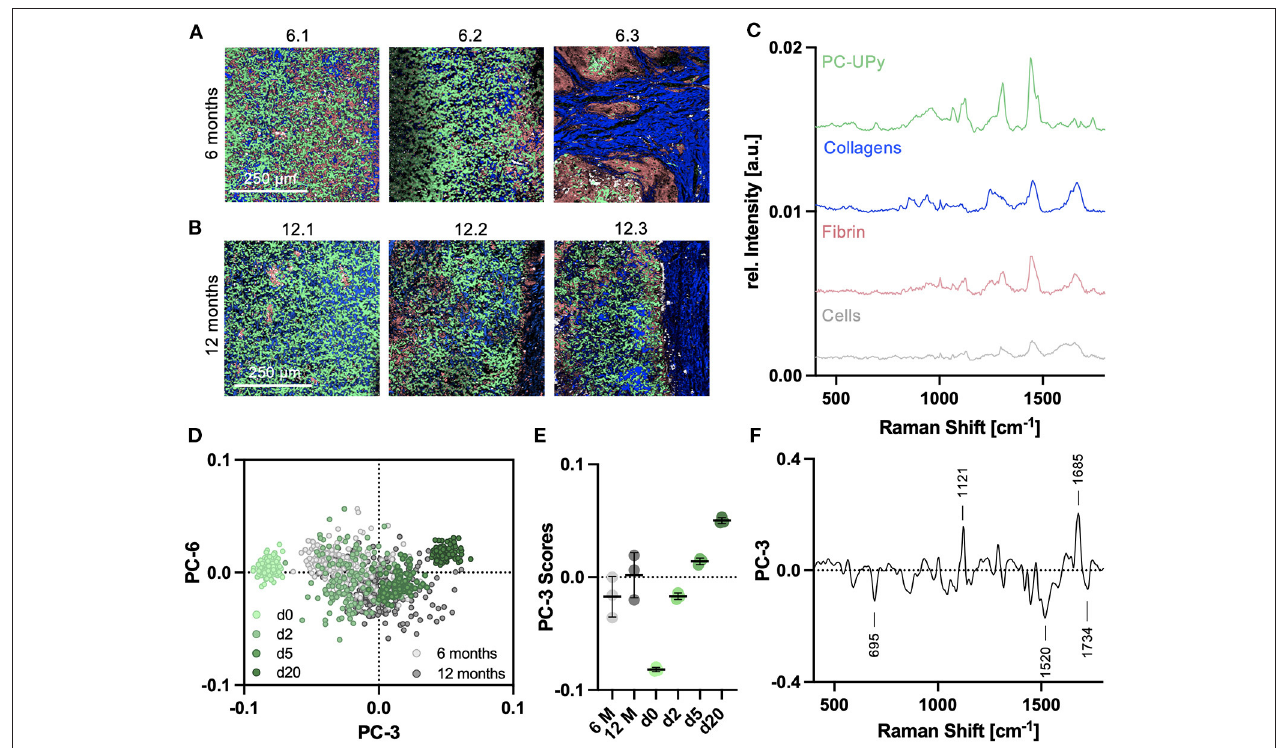
FIGURE 5 | Raman analysis of in vivo degradation of PC-UPy scaffolds. TCA Raman images of (A) 6-month and (B) 12-month explants; light green—PC-UPy, blue—collagens, light red—fibrin, white—cells, each image represents the explant from another animal, scale bar equals 250 µ m (C) Identified TCA Raman spectra could be assigned to polymer and biological signatures. (D) Spectra extracted from in vivo degradation were compared to in vitro degradation by principal component analysis. (E) PC-3 scores indicated a degradation time dependent shift with 6 and 12-months in vivo samples clustering in the range between 2 and 5 day in vitro degraded samples, n = 3, mean score values ± SD (F) Underlaying spectral changes are explained by the PC-3 loadings